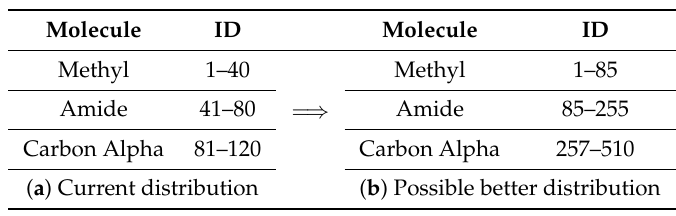
Table 1. Molecule ID